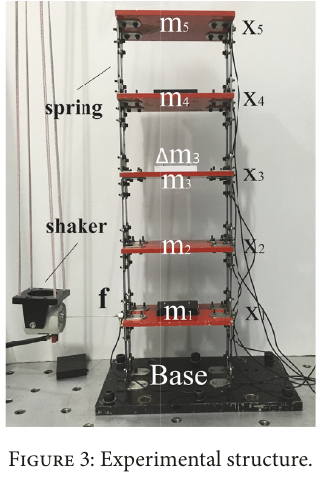
Figure 3: Experimental structure.